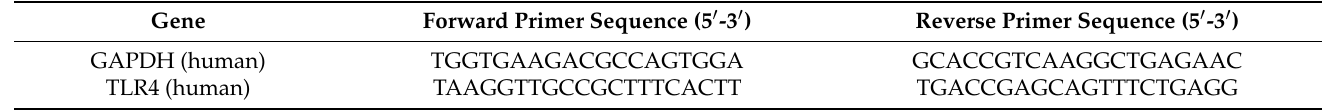
Table 3. Sequences of forward and reverse primers for quantitative real-time Polymerase Chain Reaction.